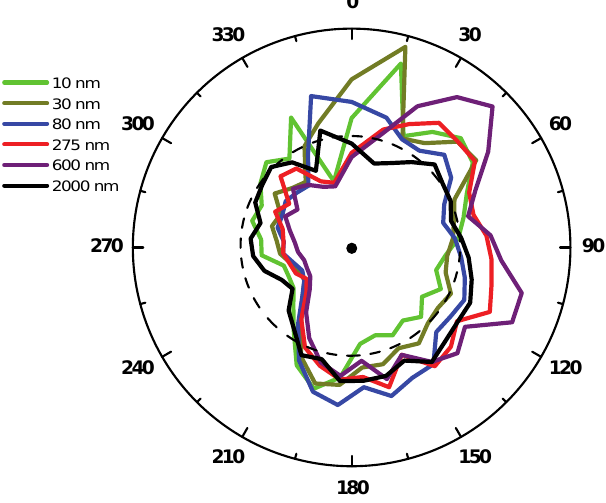
Fig. 12. Wind-directional dependence of particle number concen- tration in Augsburg. Shown is the median concentration for dif- ferent intervals of wind direction. For a better comparability, the number concentration in each size channel was normalised to